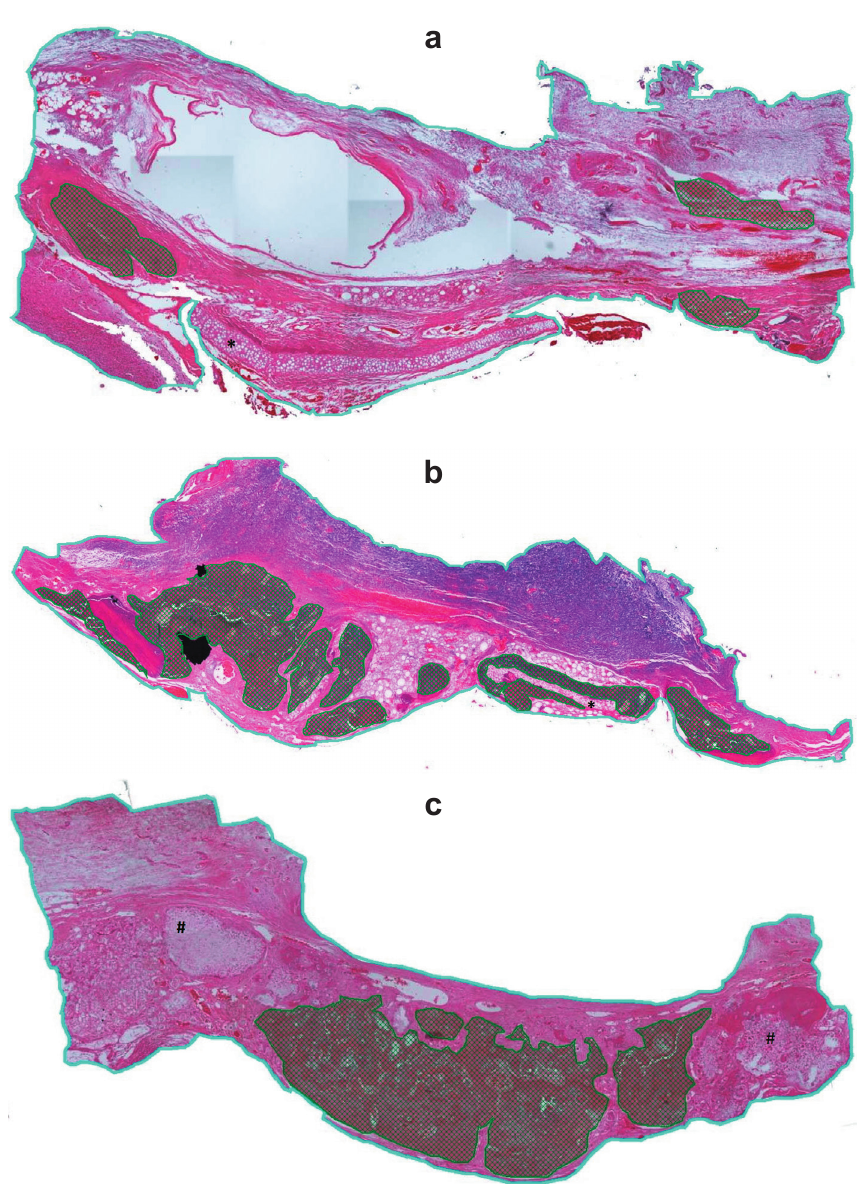
Figure 3- Histomorphometric analysis after reconstruction with autogenous bone graft, powdered synthetic hydroxyapatite implant, andallogeneic cartilage graft, with or without exposure to buried magnetic field, at 60 postoperative days (Blue lines define the total area of the bone defects, and cross hatched areas represent areas of new bone formation within the critical defect). a) Allogeneic cartilage graft group not exposed to buried magnetic stimulation; b) Allogeneic cartilage graft group exposed to buried magnetic stimulation; c) Powdered synthetic hydroxyapatite group not exposed to buried magnetic stimulation. * indicates cartilage graft; # indicates hydroxyapatite implant; ++ indicates bone